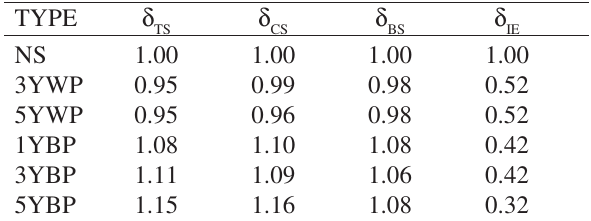
Table 2. Mean comparative parameters ( δ ) of the raised mechani- cal properties, where δ tive parameters of the traction, compression, bend and impact.